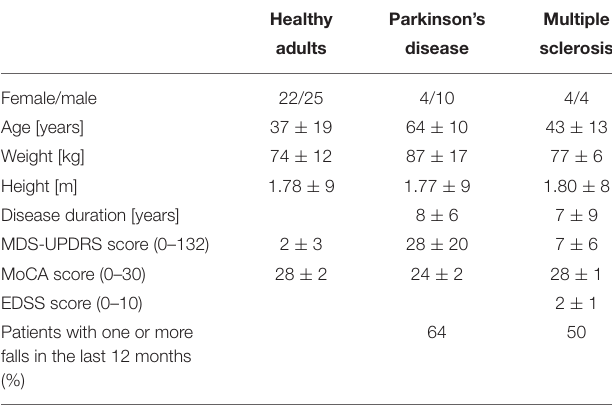
TABLE 3 | Demographics and clinical scores of the participants that were able to perform all three balance tasks. Healthy Parkinson’s Multiple adults disease